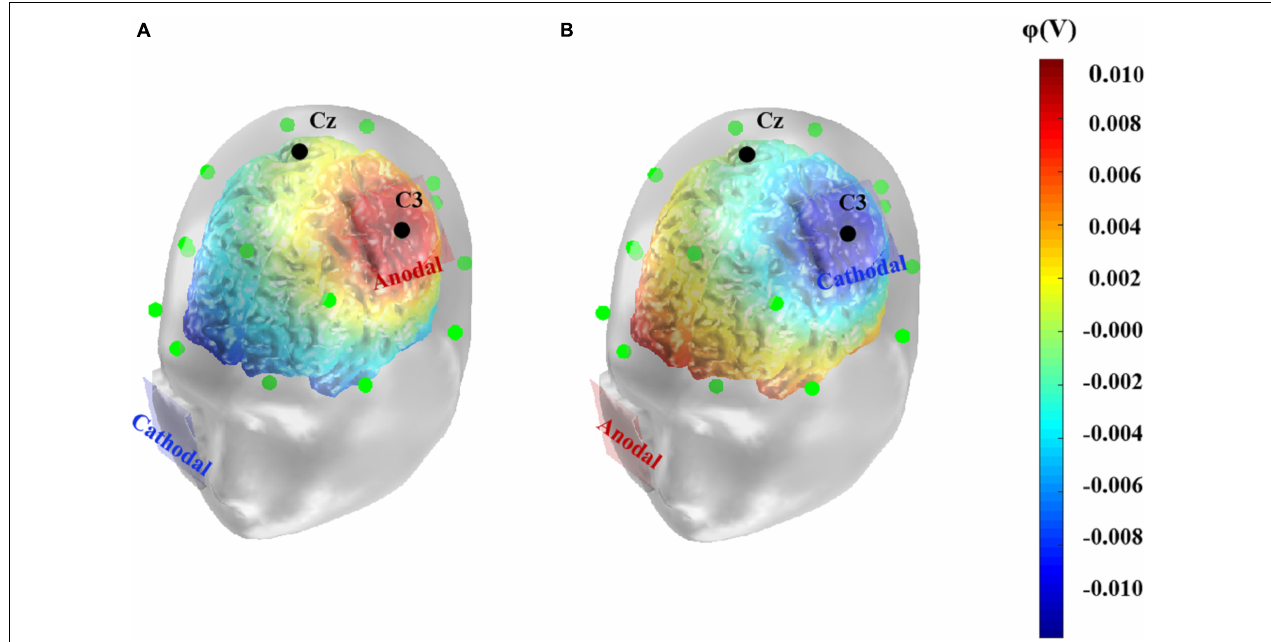
FIGURE 1 | Computational model of anodal (A) and cathodal (B) tDCS-induced electrical potential. A simulation of the electrical potential induced by tDCS over the left primary motor cortex was computed using COMETS2. The anode or cathode (5 cm × 5 cm) was placed over the left primary motor cortex, corresponding to C3 electrode according to the 10–20 EEG system. The colors denote the simulated electrical